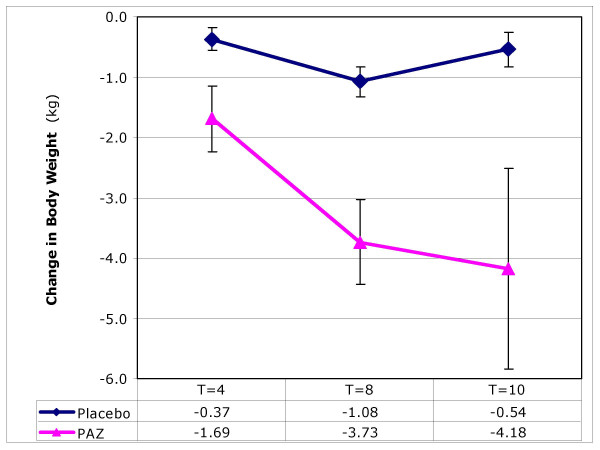
The effect of ProAlgaZyme vs. placebo on body weight (kg). Values are mean change at 4, 8 and 10 weeks compared to baseline within 95% confidence limits (+/- 1.96*(standard error of the mean)).